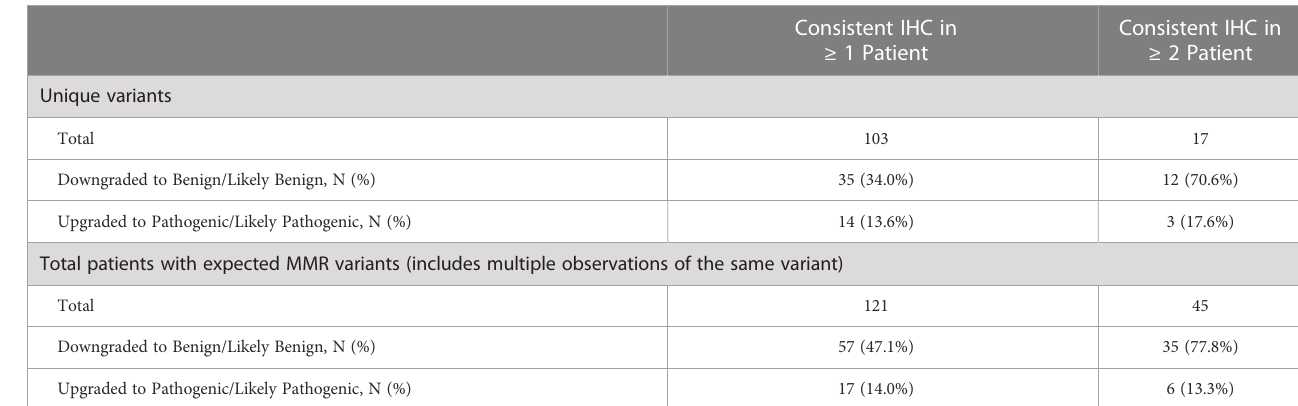
Consistent IHC in ≥ 1 Patient